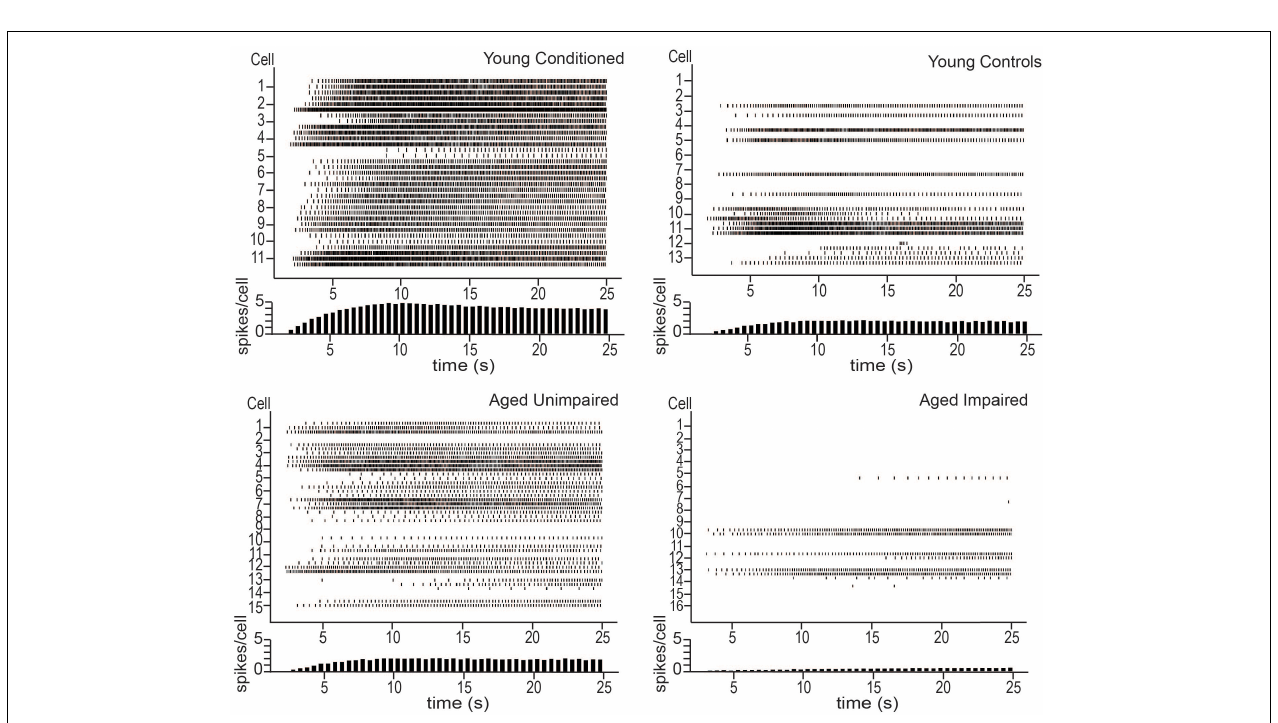
FIGURE 2 | Persistent firing activity from young animals trained on tEBC (top left) , young behavioral controls (top right) , aged unimpaired (bottom left) , and aged impaired (bottom right) animals. Persistent firing activity evoked using in vitro intracellular current injection. Three sweeps were evoked for each cell. Each row represents one sweep of activity, with each cell marked by its second sweep of activity. Below each plot is a histogram of average spikes/cell across the sweep. Young animals trained on tEBC have more persistent activity compared to behavioral controls. Aged impaired animals are relatively inactive. Reproduced from Lin et al.